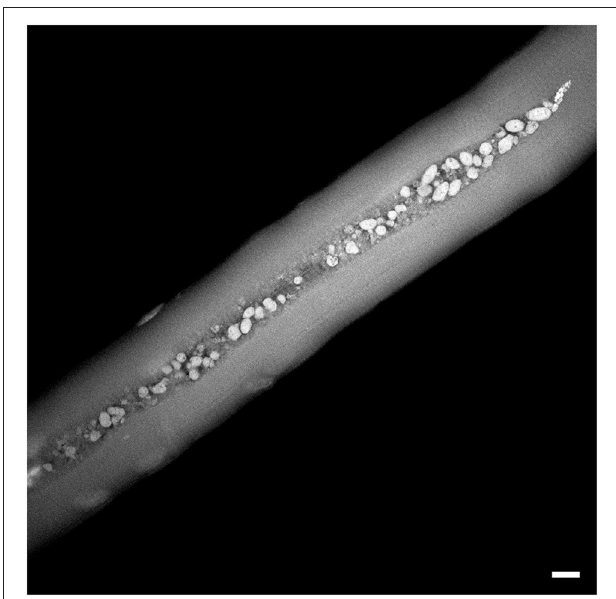
FIGURE 4 | Autofluorescent lipofuscin inclusions in a muscle biopsy from a patient (NBSL9a) with a childhood form of Pompe disease . The patient was diagnosed during a family study and began therapy at 7 years of age. The biopsy was taken prior to the initiation of ERT. Bar: 10 µ